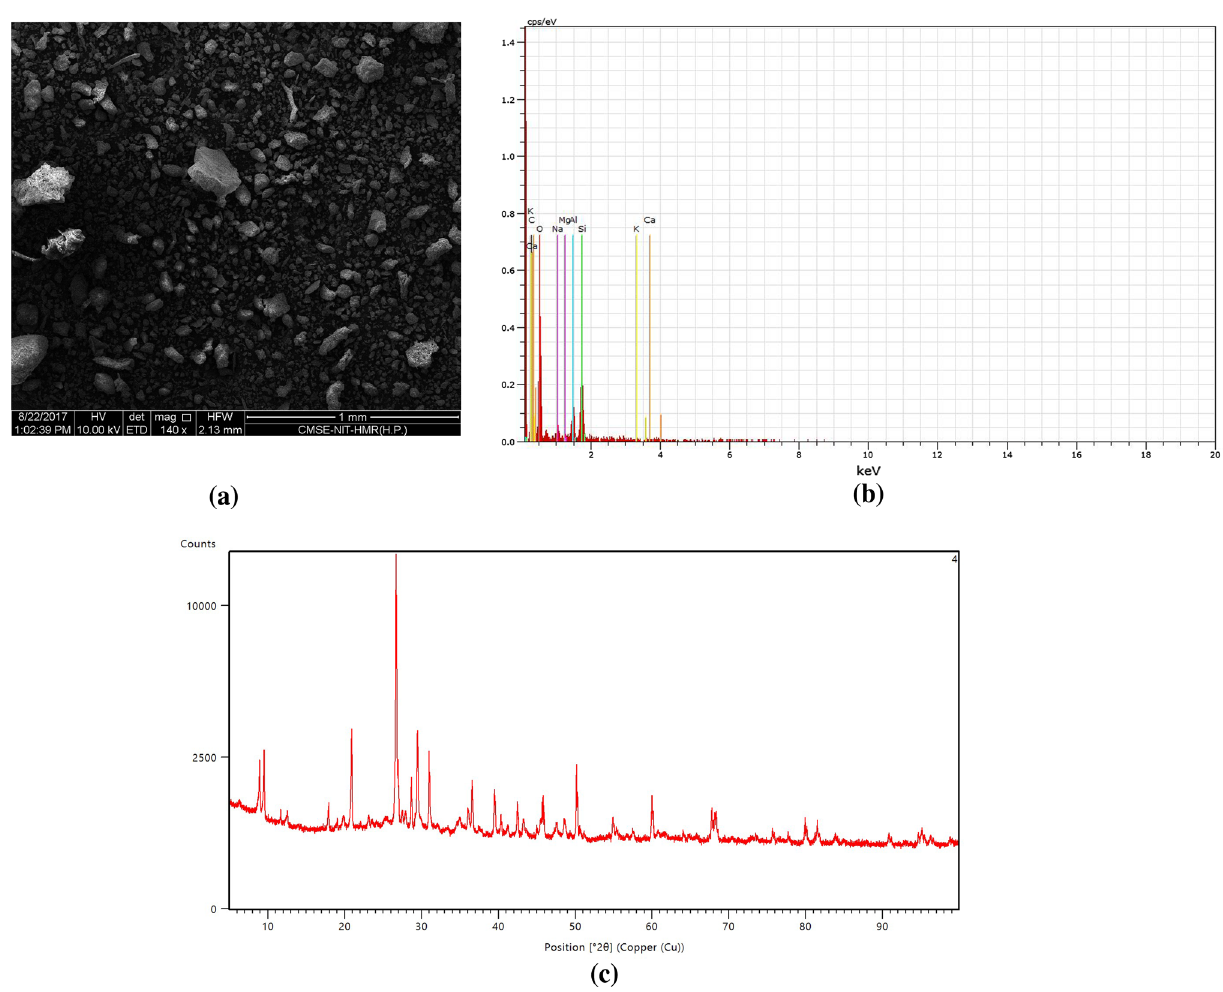
Fig. 4 SEM, EDS and XRD analyses of 60th day compost (Solan